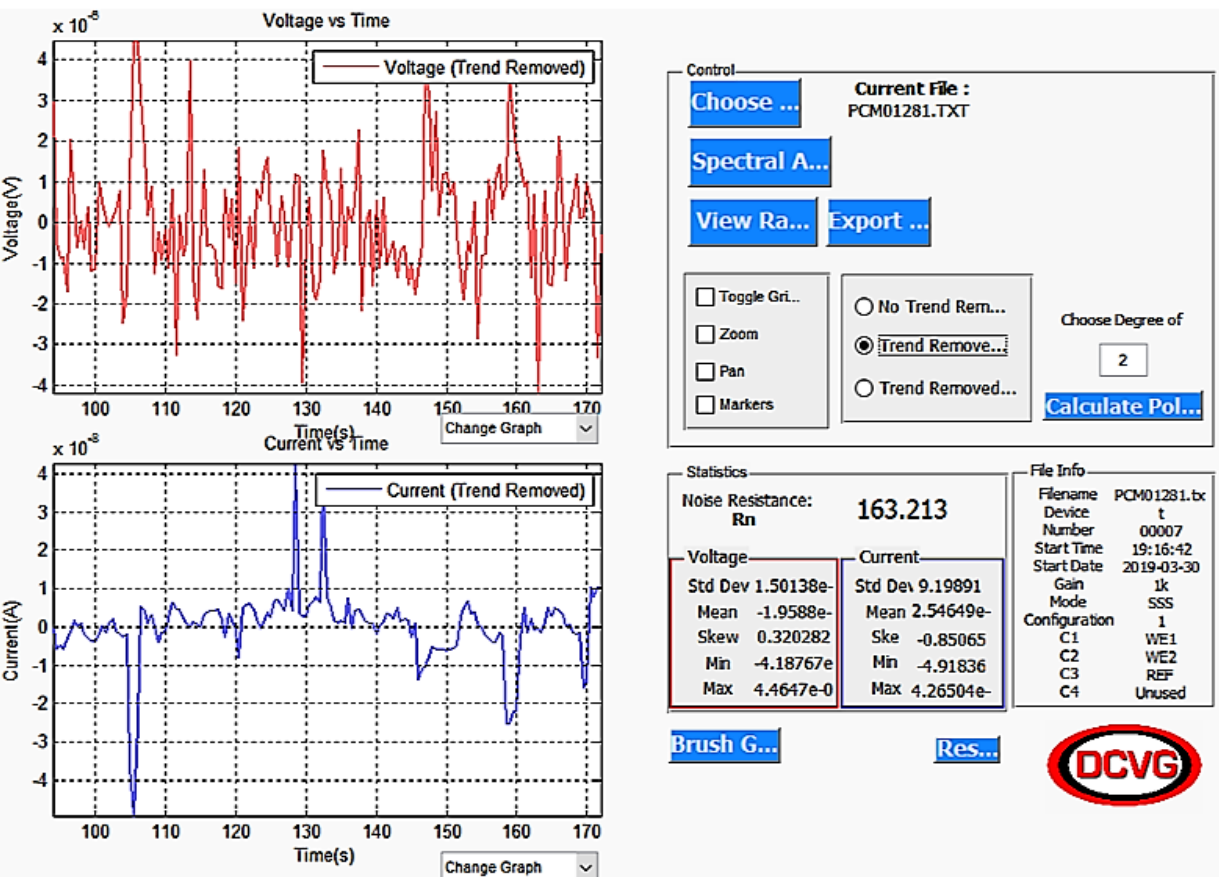
Figure 8. Example of ProCoMeter output using SSS arrangement .